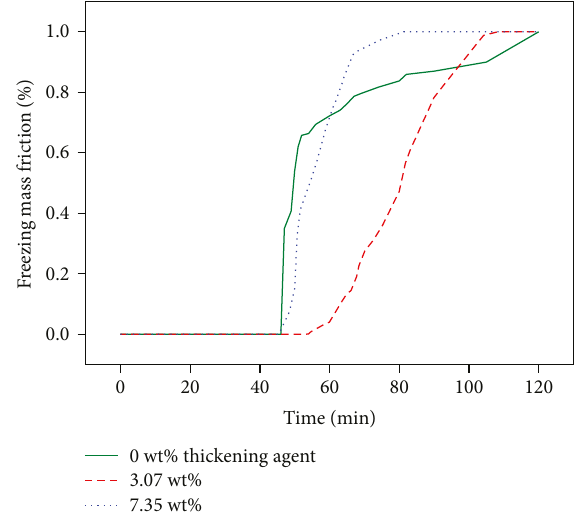
Figure 7: Solidi fi cation mass friction curve of three samples with di ff erent nucleating agents added.